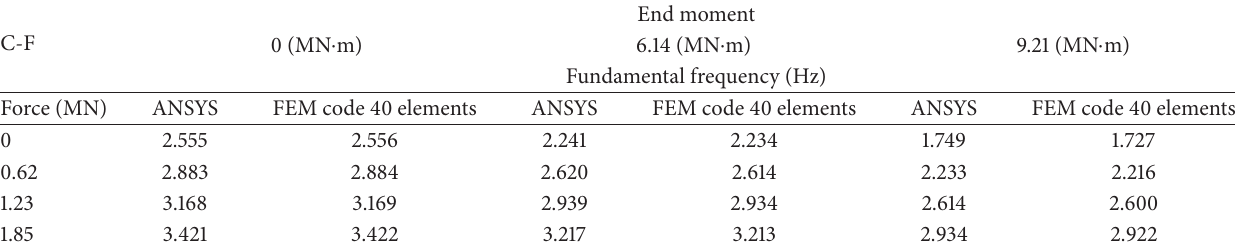
Table 2: Fundamental frequencies for cantilever beam subjected to force and end moment.